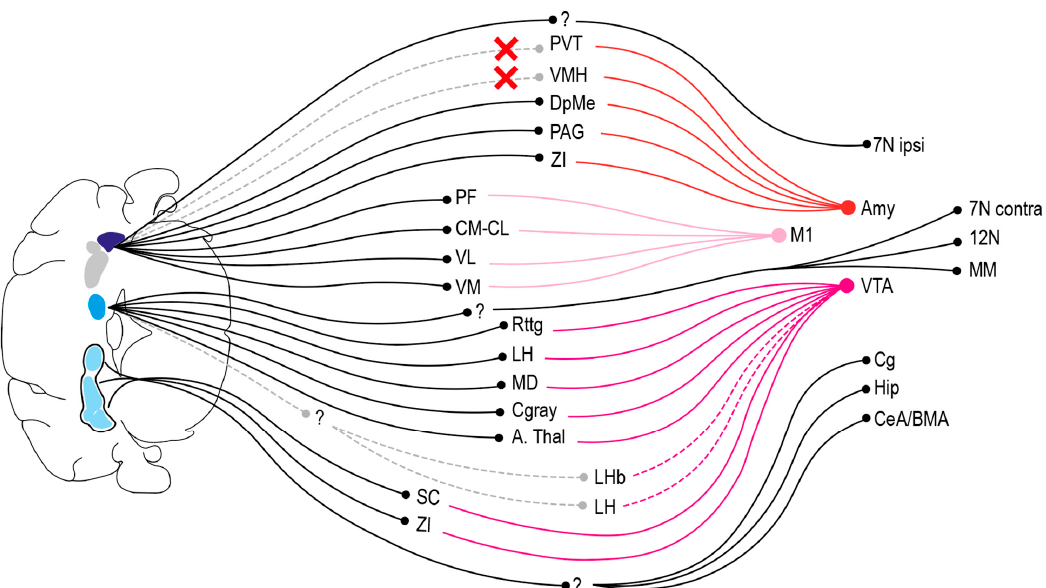
Figure 5. Schematic overview of putative di- and trisynaptic projections from CN to amygdala, M1 and VTA. Graphical summary of the data regarding which specific intermediate neurons relay cerebellar information to M1, amygdala (Amy) and VTA. The results from the MCN and LCN experiments are visualized at the top of the drawing, whereas the results of the MCN-INT-LCN injections are visualized in the bottom. Additionally, unknown intermediates of disynaptic or trisynaptic connections are represented by a ‘?’. Dotted lines represent proposed connections that have yet to be proven, where a red X represents a connection that we failed to identify. This graphical summary is based on the data obtained in these experiments. As such, the absence of a particular connection in this overview is not meant to represent the absence of its existence; only positive results are represented. Abbreviations: 7N, facial nucleus; 12N, hypoglossal nucleus;